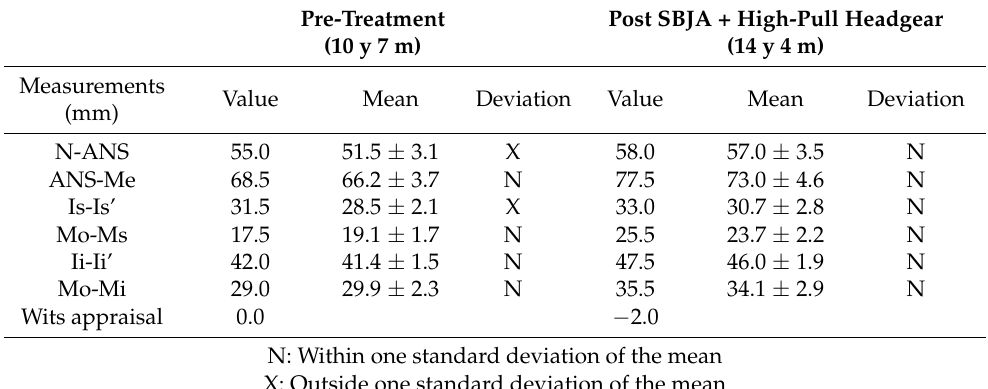
Table 2. Cephalogram distance measurements of Case 1.